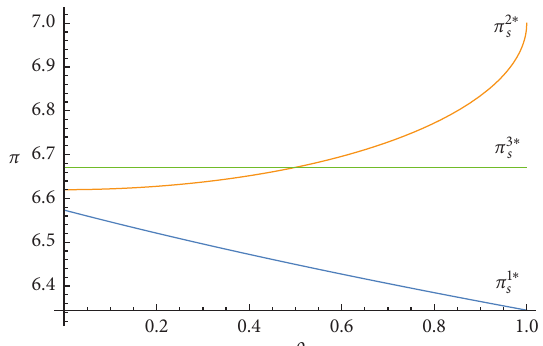
Figure 2: Effects of ρ on the maximum expected profit of the supplier.